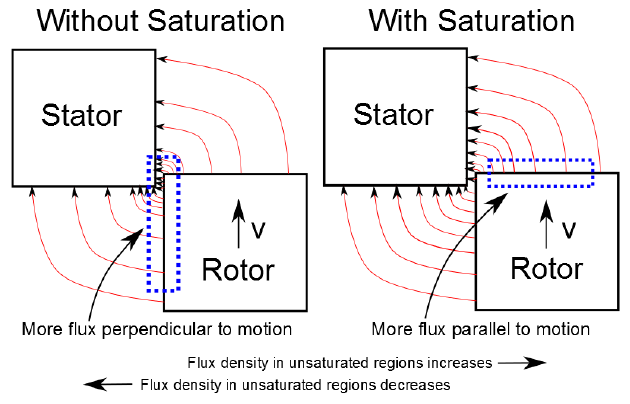
Figure 1. Best physical alternative pole configuration.